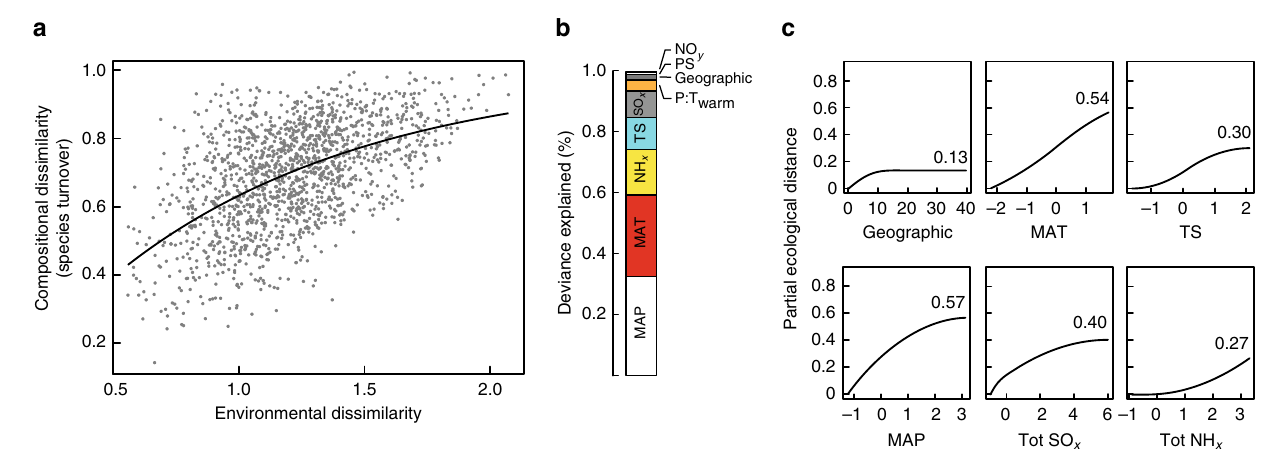
Fig. 2 Taxonomic turnover along environmental gradients. a Relationship between observed plant community compositional dissimilarity between site pairs (species turnover or β -diversity) and their predicted environmental dissimilarity. The line represents the linear predictor of the regression equation from generalized dissimilarity modelling (GDM, Methods section). b Reduction in deviance explained between full model and model with the environmental variable omitted, i.e., an indicator of the proportion of deviance attributed to that variable. Variables tested were geographical distance, mean annual temperature (MAT), seasonality in temperature (TS), mean annual precipitations (MAP), seasonality in precipitation (PS), ratio of precipitation and temperature of the warmest quarter (P:T warm ), sulphate (SO x ), and reduced (NH x ) and oxidised (NO x ) nitrogen atmospheric depositions. c Partial regression fi ts (Model- fi tted-I-splines) for variables signi fi cantly associated with plant community species turnover. Note that we also included geographical distance for reference. The maximum height (inset number) reached by each I-spline curve indicates the relative importance of that variable in explaining beta diversity, keeping all other variables constant (i.e., the partial response curve value). The shape of each function provides an indication of how the rate of compositional turnover varies along the environmental gradient